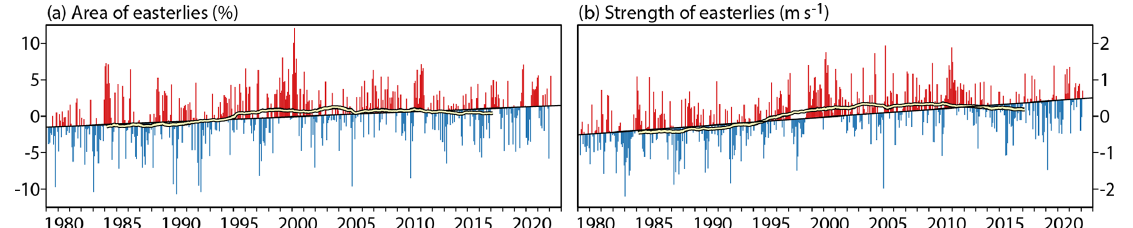
Figure 9. Monthly means of (a) the area with an easterly component of 200hPa wind between latitudes 30 ◦ N and 30 ◦ S as a percentage of the total area between these latitudes and (b) the strength (ms − 1 ) of the easterly component of the wind averaged over this area. Values are shown relative to the average for each month in the period from March 1979 to February 2022 and plotted according to whether they are above (red) or below (blue) the least squares fit linear trend for this period. Yellow lines edged in black show 120-month running